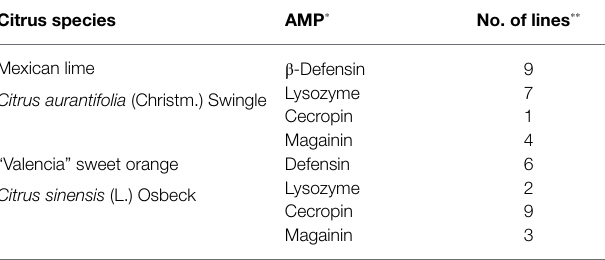
TABLE 1 | Positive Citrus transformed plants with the CsPP16-AMP fused proteins. Citrus